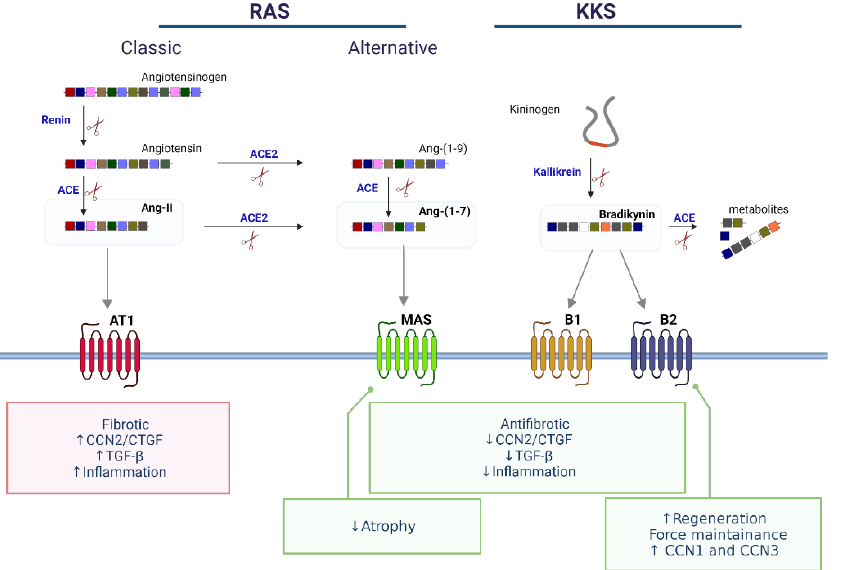
Figure 3. RAS and KKS in skeletal muscle. The subsequent enzymatic cleavage (shown as scissors) of Angiotensinogen and Kininogen, leads to the release of active peptides which activate specific receptors. The Renin-Angiotensin System (RAS) and the Kallikrein-Kinin System (KKS) of vasoactive peptides modulate CCN2/CTGF and possibly other CCNS, regulating skeletal muscle fibrosis. The activation of the canonical RAS promotes CCN2/CTGF, muscle fibrosis, and inflammation. On the other hand, alternative RAS and KKS protect skeletal muscle from damage and fibrosis. Figure created with BioRender.com (accessed on May 14 th , 2021).